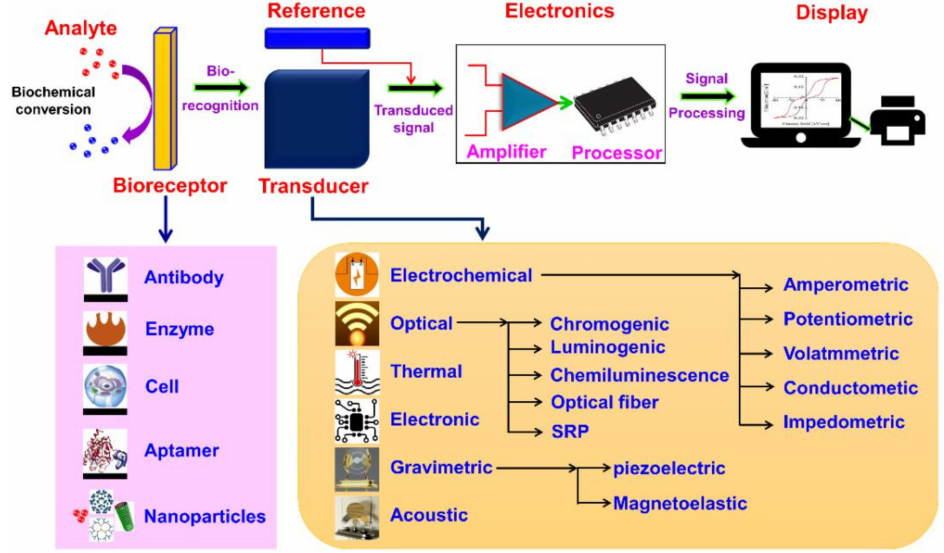
Figure 1. Biosensors and their components (reprinted from Ref. no. [1], copyright 2021,